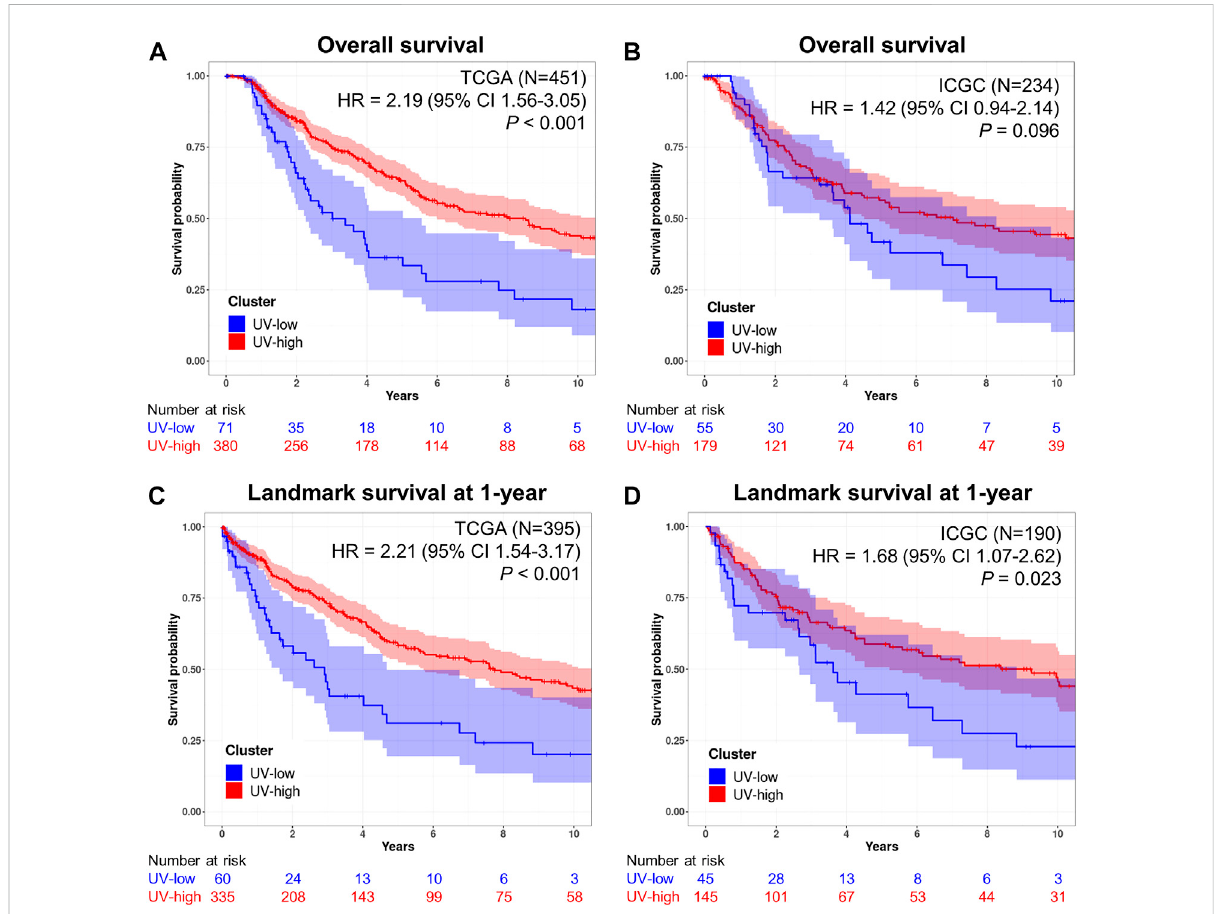
FIGURE 3 Prognosticimplications of mutational signatures. (A) Kaplan – Meier curves for overall survival of UV-low (blue) and UV-high (red) clusters in the TCGA dataset ( N = 451). (B) Kaplan – Meier curves for overall survival of UV-low (blue) and UV-high (red) clusters in the ICGC dataset ( N = 234). (C) Kaplan – Meier curves for landmark survival at 1-year of UV-low (blue) and UV-high (red) clusters in the TCGA dataset ( N = 395). (D) Kaplan – Meier curvesforlandmarksurvivalat1-yearofUV-low(blue)andUV-high(red)clustersintheICGCdataset( N